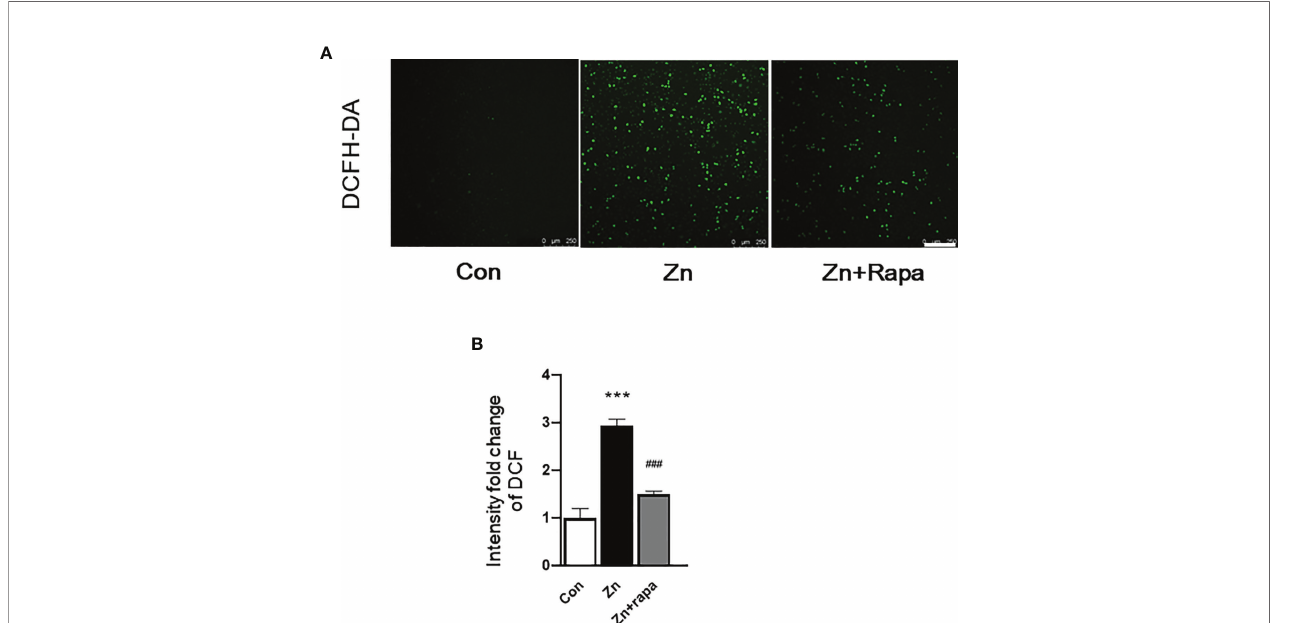
FIGURE 3 | Rapamycin suppressed reactive oxygen species (ROS) generation caused by zinc in SH-SY5Y cells. (A, B) Representative fl uorescent staining and quanti fi cation of the fl uorescence intensity of ROS determined by 2 ’ -7 ’ dichloro fl uorescin diacetate (DCFH-DA) staining in SH-SY5Y cells of the control, zinc, and zinc +rapamycin groups. Scale bar = 250 m m. n = 3 cell experiments per group, all confocal images represented as fold change relative to control cells. ***p < 0.001 vs. the control group; ###p < 0.001 vs. zinc+rapamycin